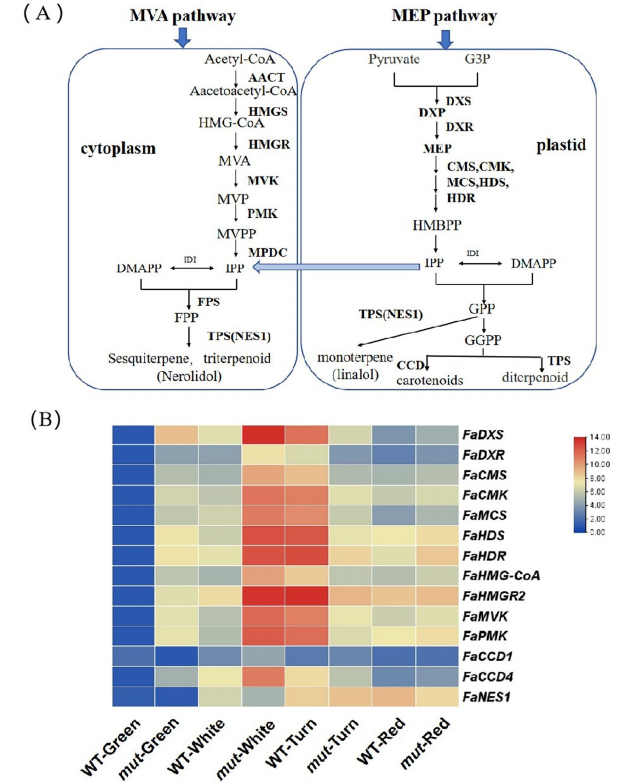
Figure 6. Terpenoid pathway analysis. ( A ) Schematic diagram of terpenoid pathways. Abbrevia ‐